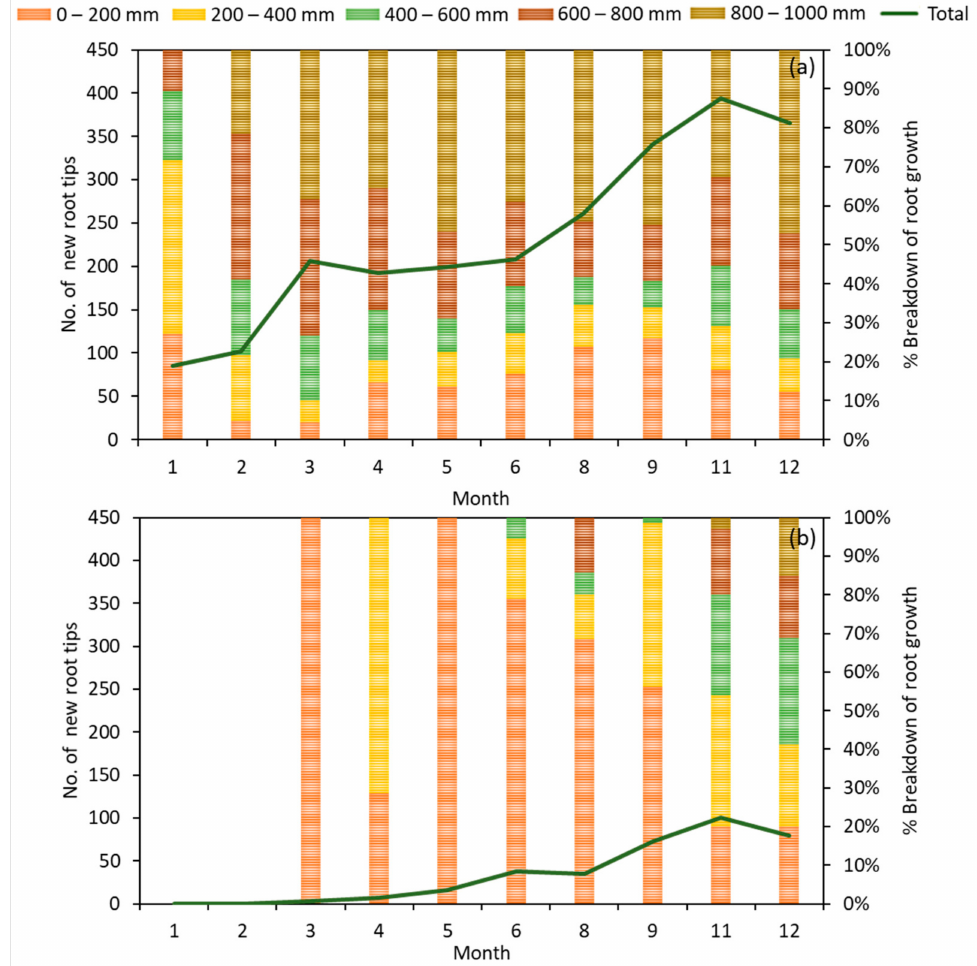
Figure 6. ( a ) The number of new root tips observed at different depths of the biofilters planted with Talipalitri tiliaceum , TT1 and ( b ) Sterculia macrophylla , TT2 in the bioretention system for the pilot study over a period of 12